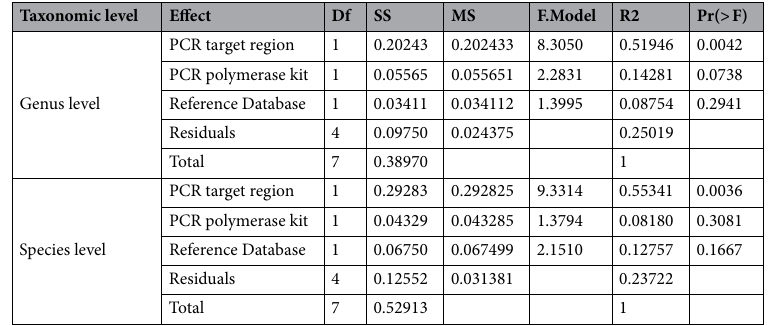
Table 1. PERMANOVA of mock community. Model includes PCR target region, PCR polymerase kit, and reference database. Df degrees of freedom; SS sum of squares; MS mean squares; R 2 coefficient of determination.